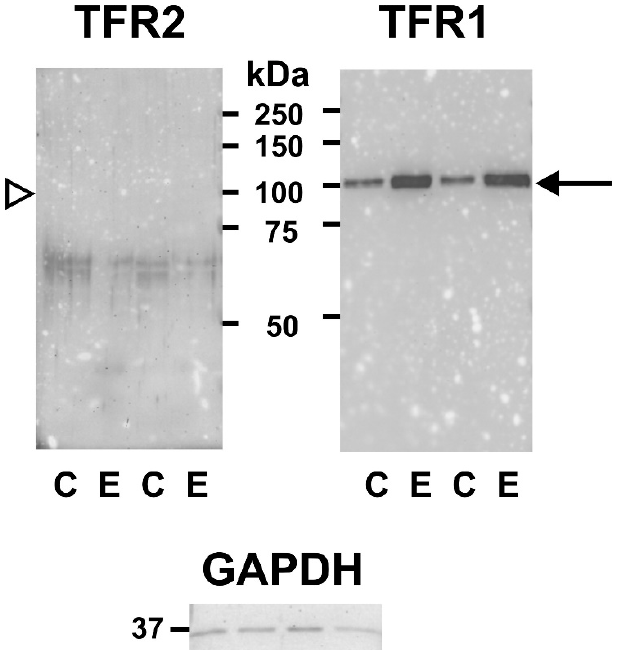
Figure 6. Single injection of EPO increases TFR1 protein content in plasma exosomes. Immunoblot- ting for TFR2 and TFR1 in plasma exosomes isolated from control (C) and EPO (E) treated mice. EPO was administered at 200 U/mouse; mice were sacrificed 72 h after EPO injection. Arrow denotes the TFR1-specific band, arrowhead indicates the expected size of exosomal TFR2, which was not detected. The faint bands around 65 kDa in the TFR2 panel are probably nonspecific. GAPDH is used as loading control.